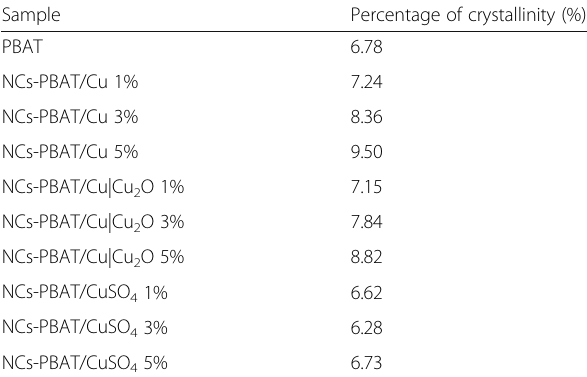
Table 1 Percentage of crystallinity of each of the mixtures